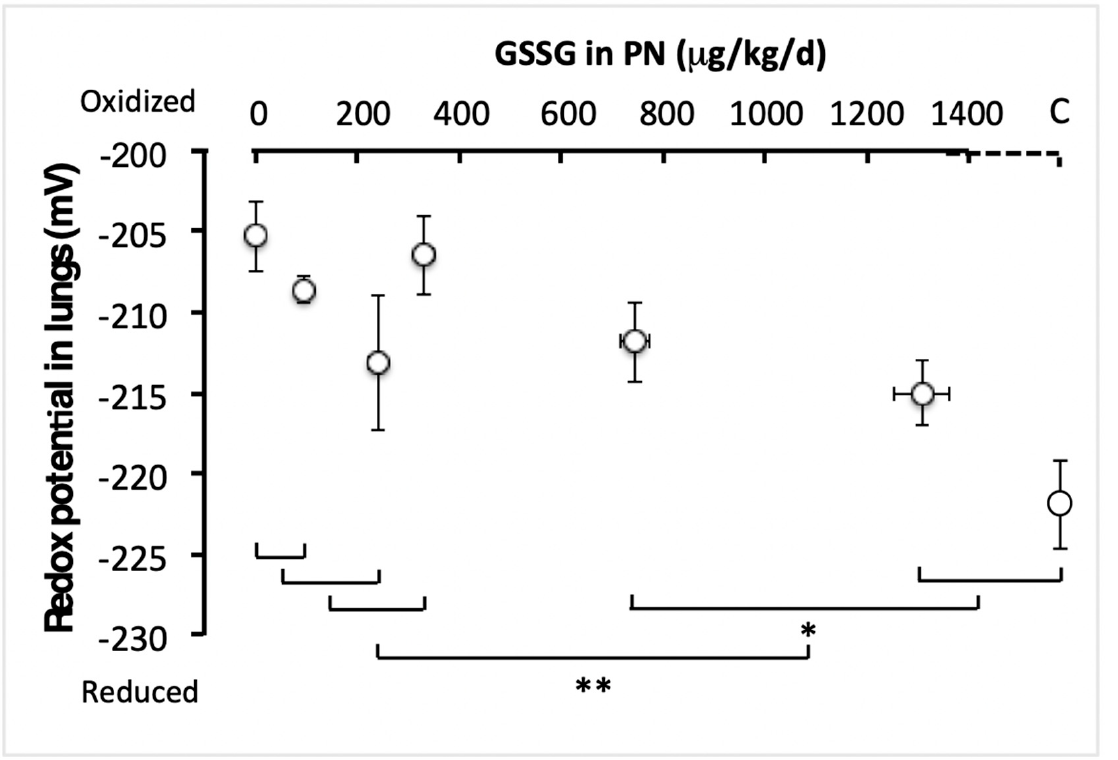
Figure 2. Pulmonary redox potential of glutathione as a function of increasing GSSG added to PN. The control (C) value was added to the abscissa after the highest dose of GSSG. The orthogonal comparisons were 0 vs. 95 µg/kg/d (no statistical difference), the two vs. 240 µg/kg/d (no difference), the first three doses vs. 330 µg/kg/d (no difference). The highest dose (1300 µg/kg/d) was not statistically different from the control, while the two were statistically different ( p < 0.05) from 750 µg/kg/d. The highest doses (750 and 1300 µg/kg/d) and the control were statistically different ( p < 0.001) from the lowest doses (0 to 330 µg/kg/d). Mean ± S.E.M. for redox values ( y axis) and doses ( x axis). The bars indicate the orthogonal comparisons; the absence of significant difference is shown by the absence of symbol above the bar; *: p < 0.05; **: p < 0.001; n = 6–11 per